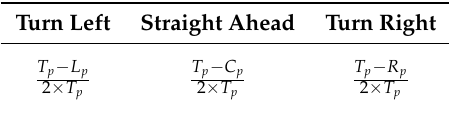
Table 4. UAV action table with